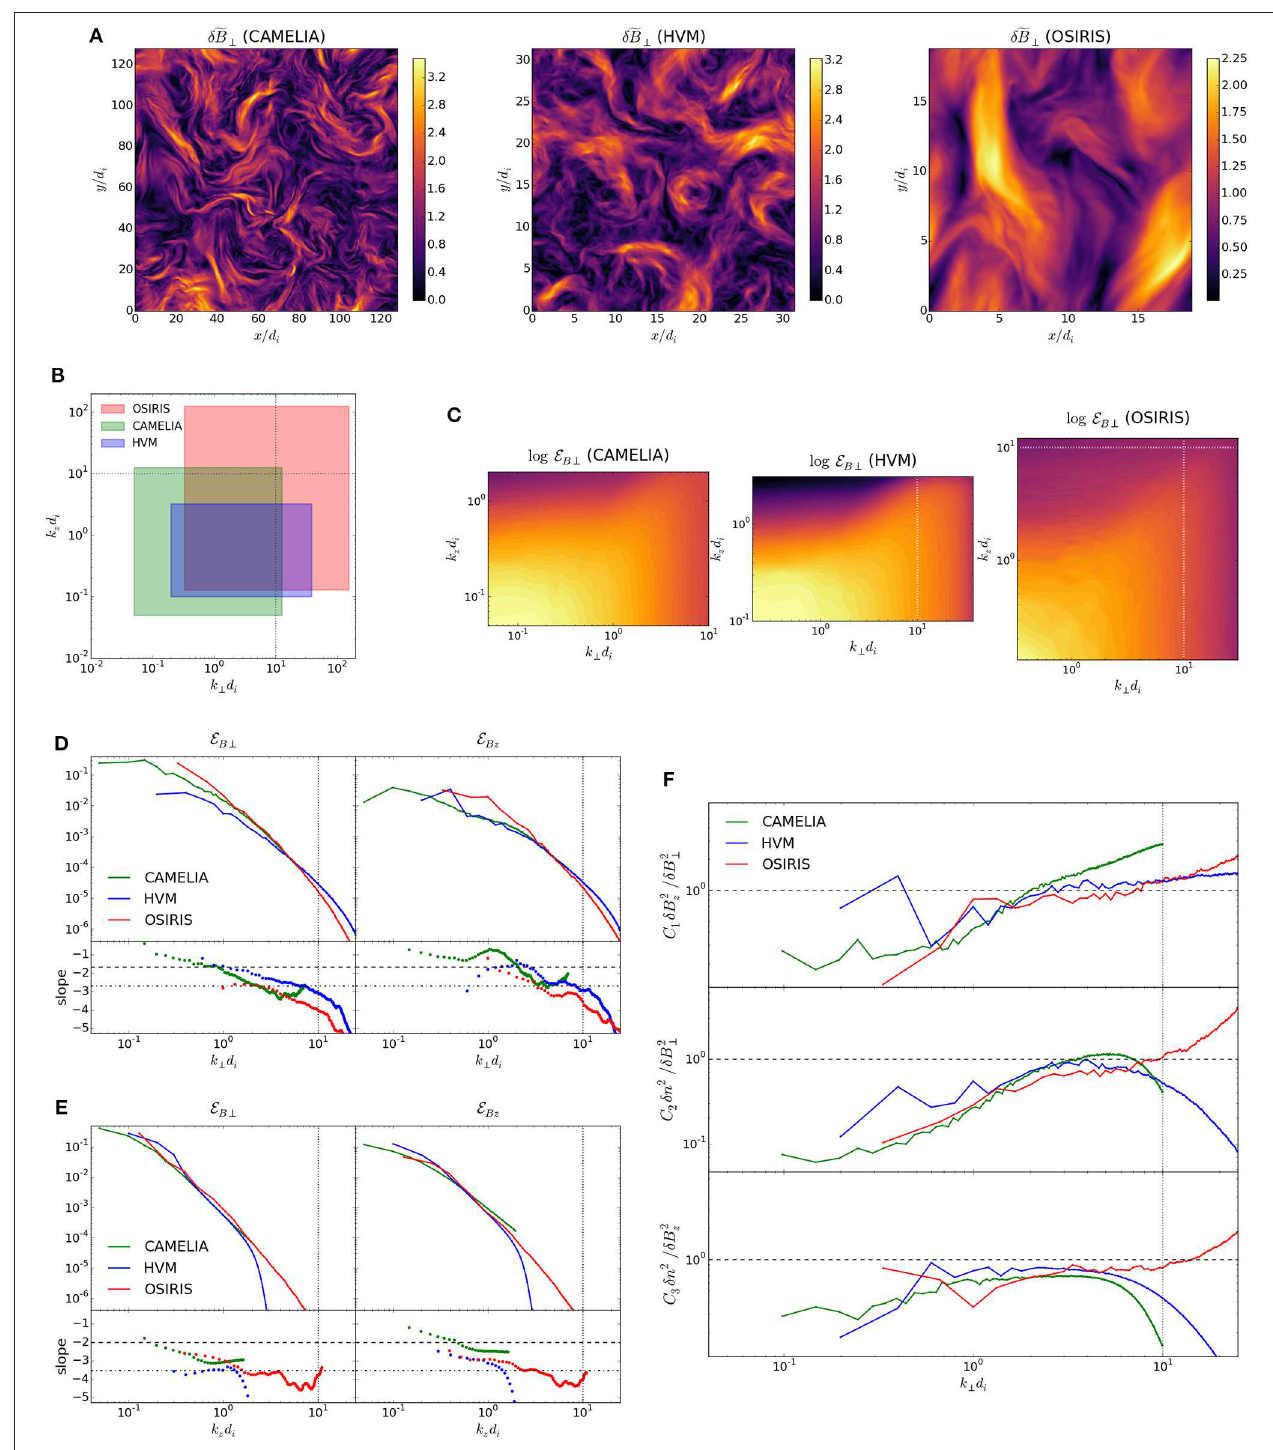
B δ B /δ B (rms) FIGURE 1 | (A) δ in a plane perpendicular to B 0 . (B) Nominal wavenumber-space representation of simulations. (C) δ B e ⊥ = ⊥ ⊥ space. White dotted lines mark kd e 1. (D) Top panels: reduced spectra vs. k = Horizontal lines denote 5 / 3 (dashed) and 8 / 3 (dash-dotted) slopes. Vertical dotted line marks k − − (dash-dotted) slopes are marked for reference. (F) Spectral ratios vs. k